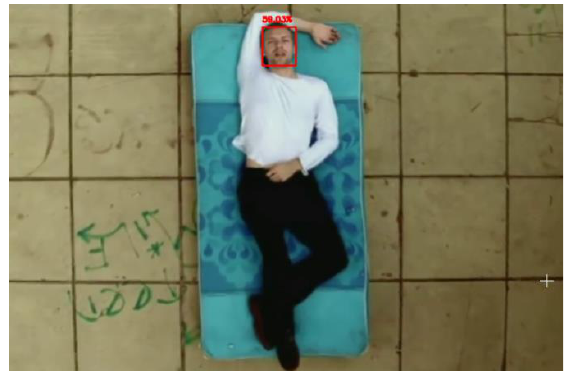
Figure 8. Result showing face detection in video using our proposed model [88].